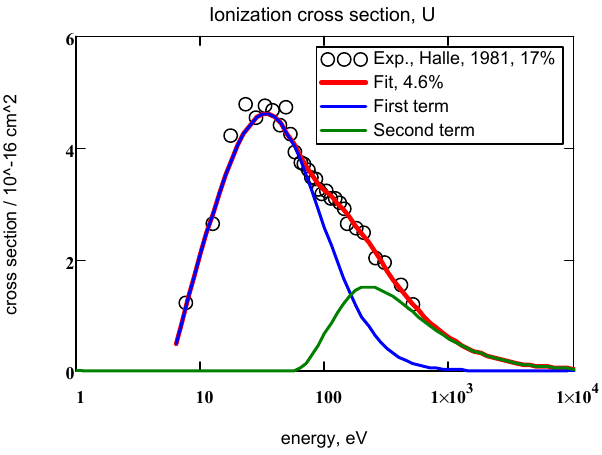
Figure 9. Experiment [30] and the result of approximation by the two − term Formula (7) of the ionization cross section of uranium atoms with a mean square relative error of 4.6%.